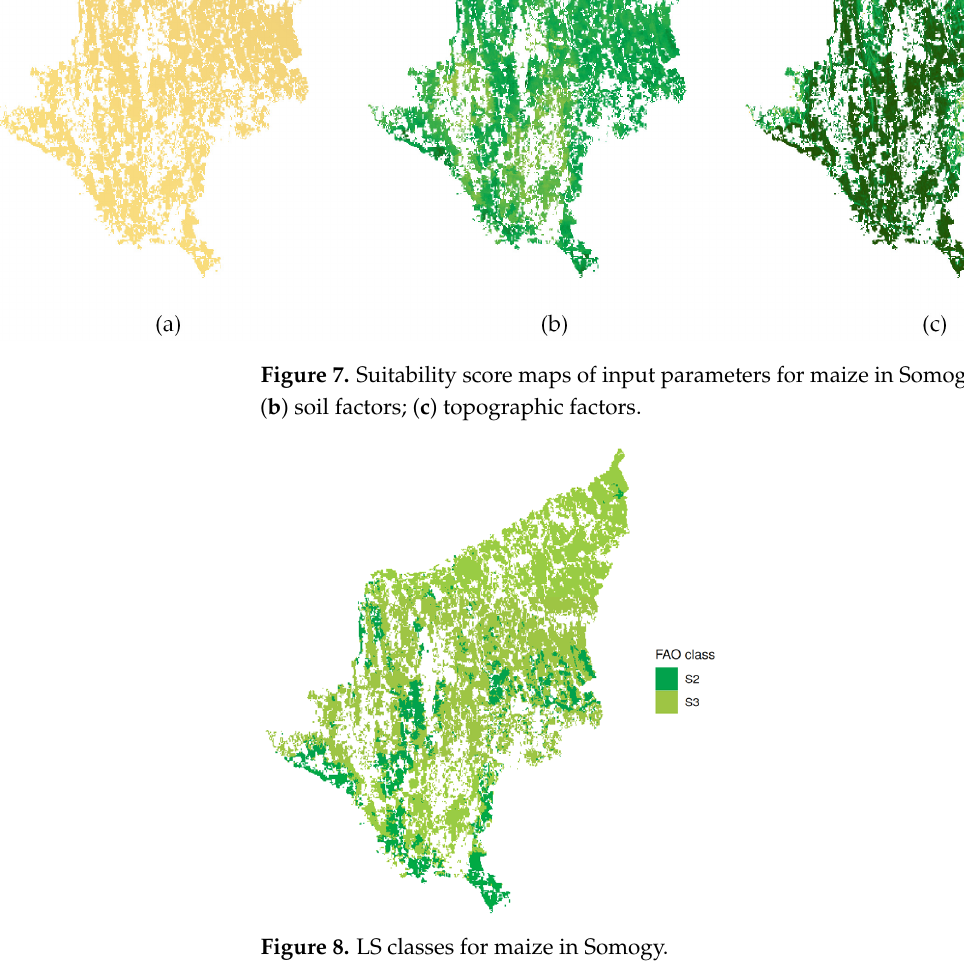
Figure 8. LS classes for maize in Somogy .